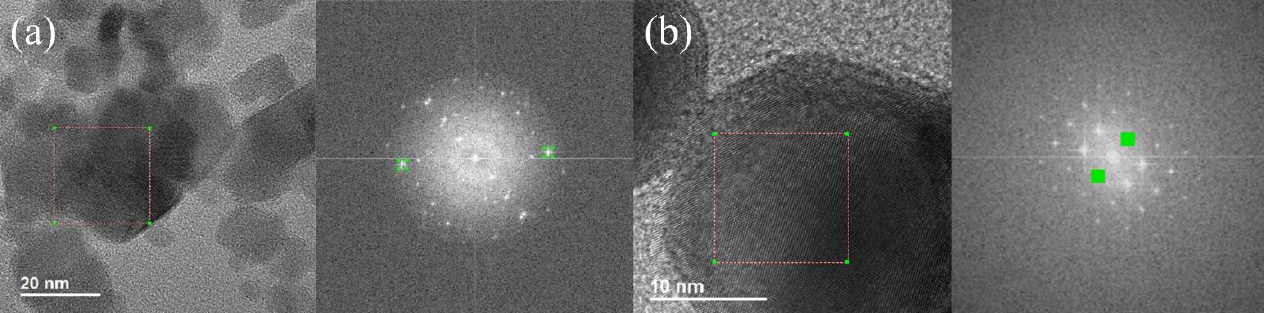
Figure 4. TEM images with selected area for FFT denoted by the red dashed box and the correspond- ing diffraction patterns of ( a ) MNPs and ( b ) MAuNPs.